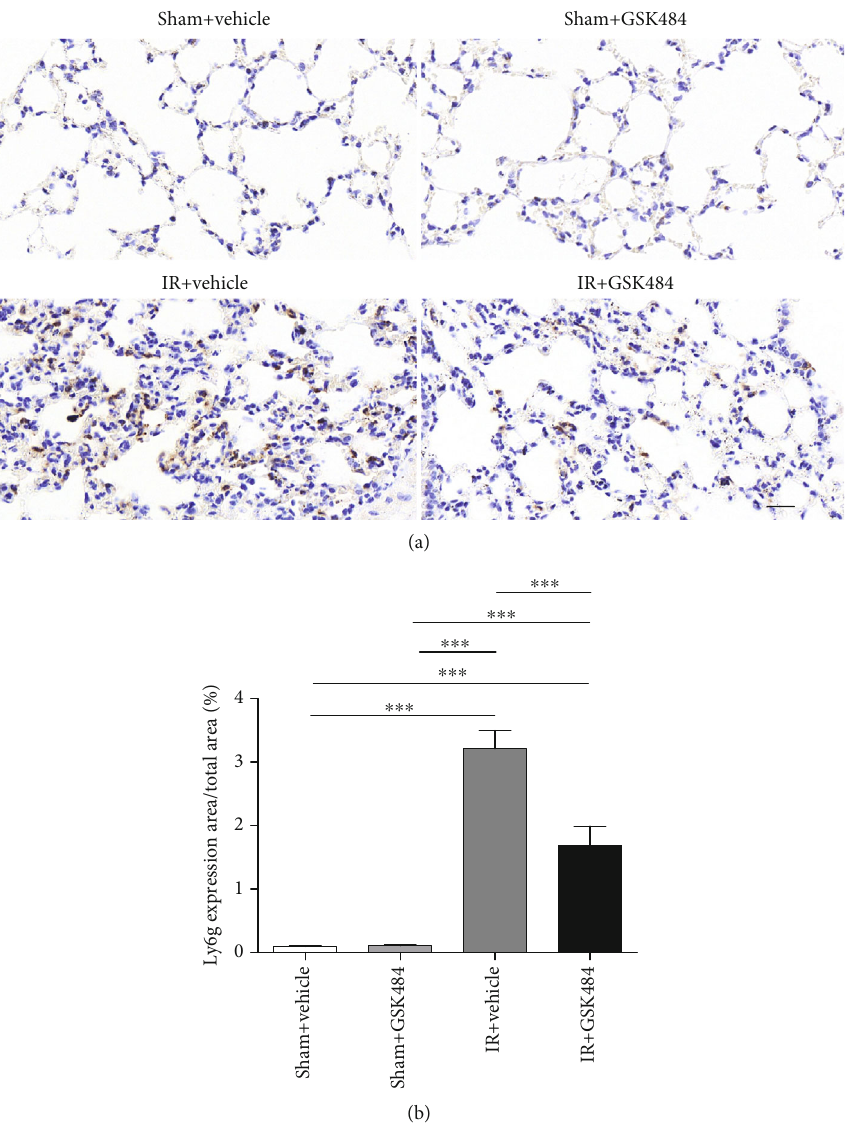
Figure 5: E ff ect of GSK484 on pulmonary neutrophil in fi ltration after renal IR-induced pulmonary injury. (a) Immunohistochemical staining for LY6G was performed on lung sections from di ff erent treatment groups (scale bar: 50 μ m). (b) Quanti fi cation of LY6G-positive cells. The values are presented as the means ± SEMs ; n = 6 ; ∗∗∗ p < 0 : 001